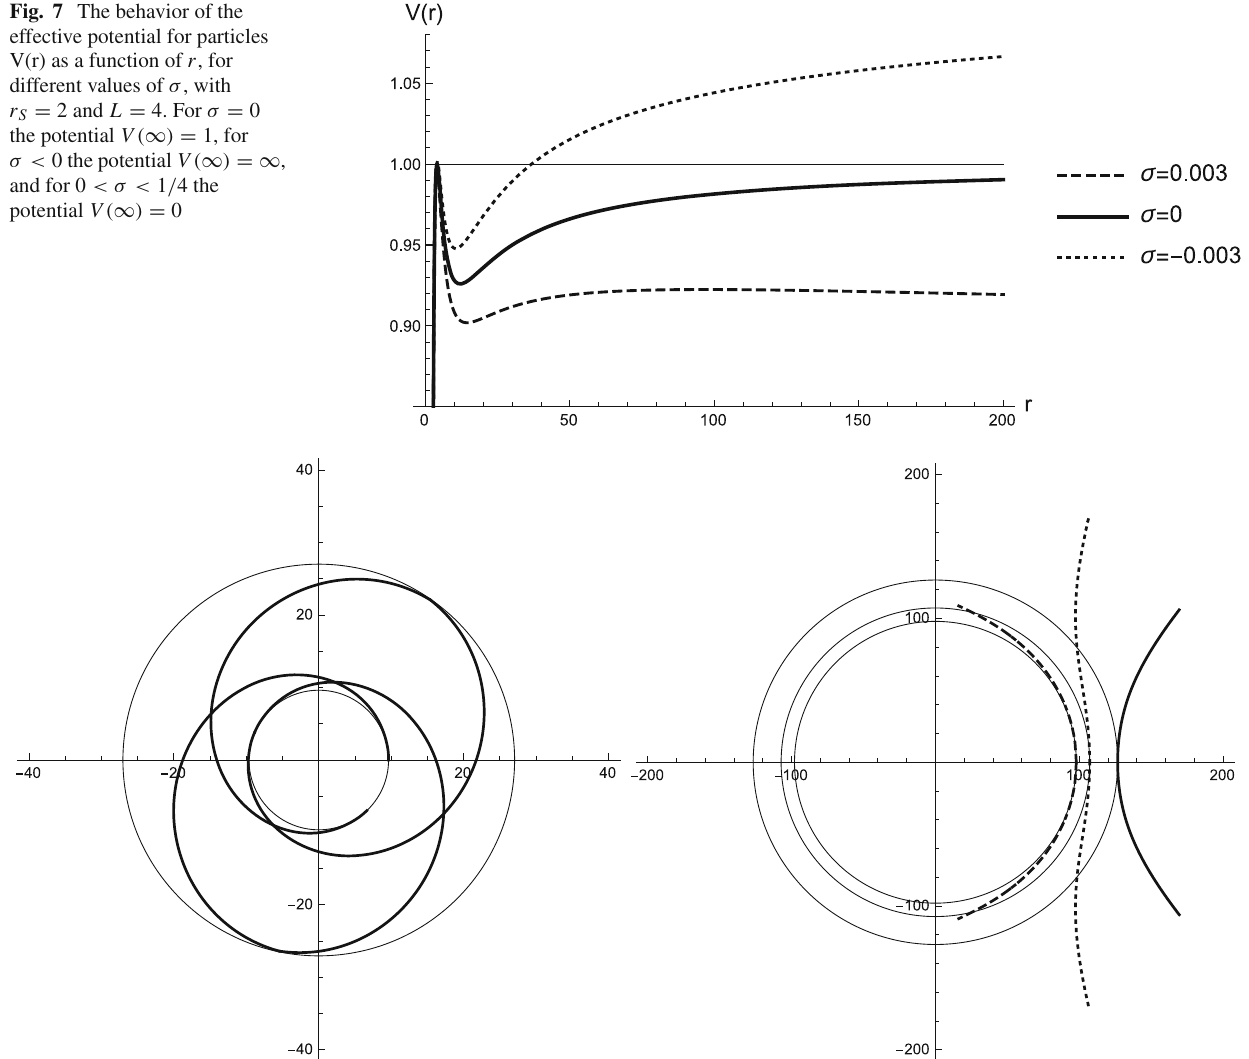
of energy, the continuous line corresponds to E 2 = 0 . 922 (repulsive scattering), the dashed line corresponds to E 2 = 0 . 92247 (attractive scattering), and the dotted line corresponds to E 2 = 0 .